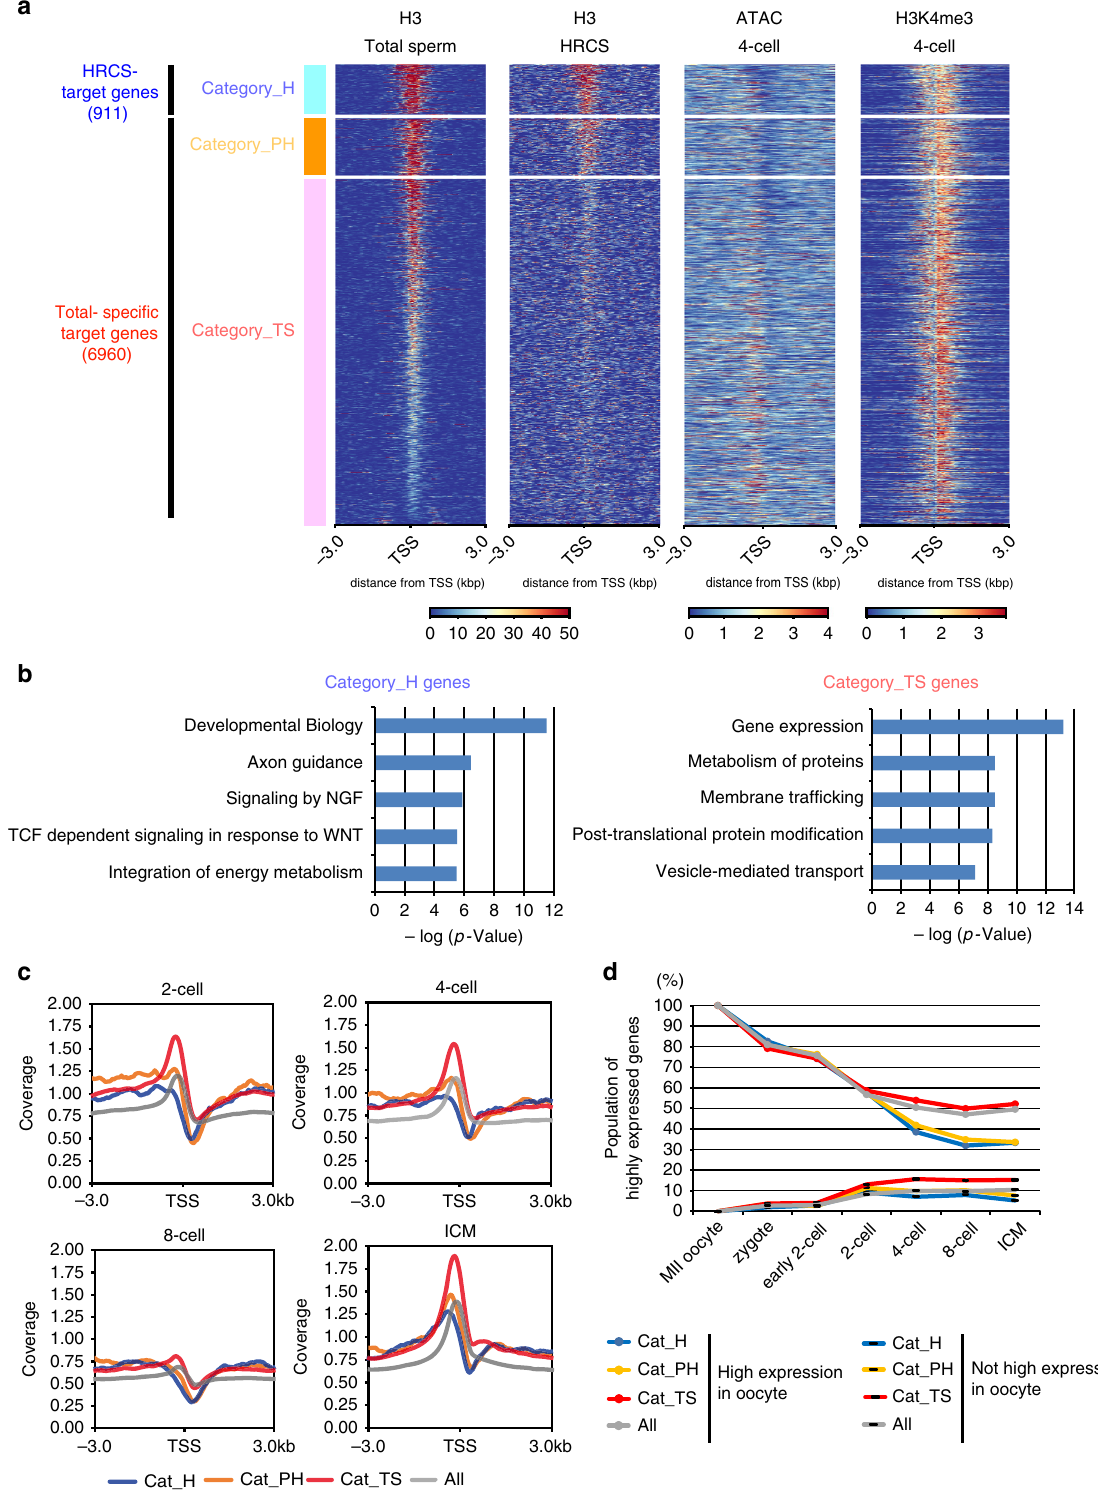
lower ATAC-seq and H3K4me3 ChIP-seq signals than category_TS genes, suggesting that the chromatin structure of category_H/PH genes exhibits lower DNA accessibility and slightly weaker transcriptional activity than that of category_TS genes at this stage (Fig. 4a) (Supplementary Fig. 8b and